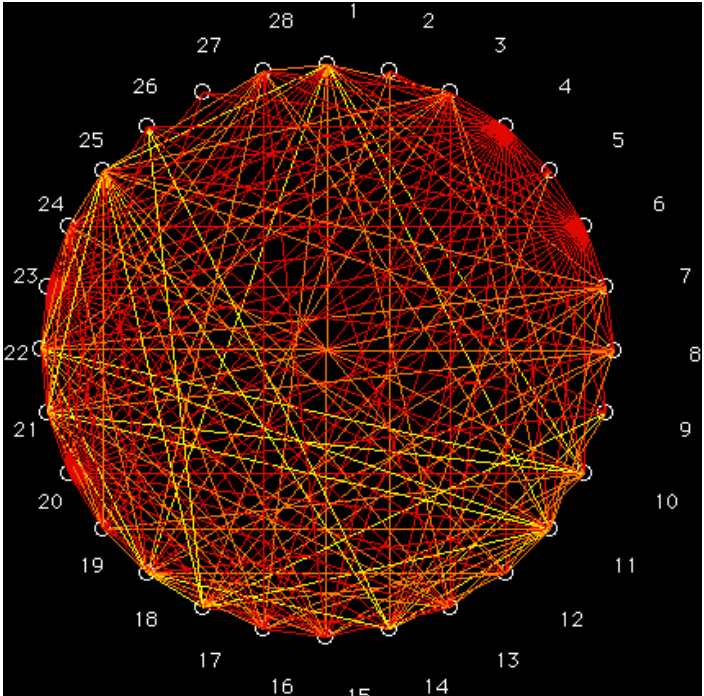
Figure 1. Partial correlation diagram: High ( red ), medium ( orange ) and low ( yellow )